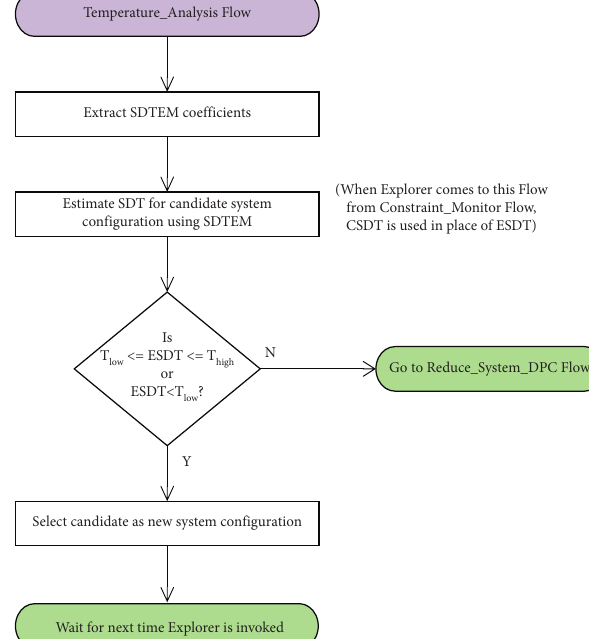
Figure 7: Temperature_Analysis flow of